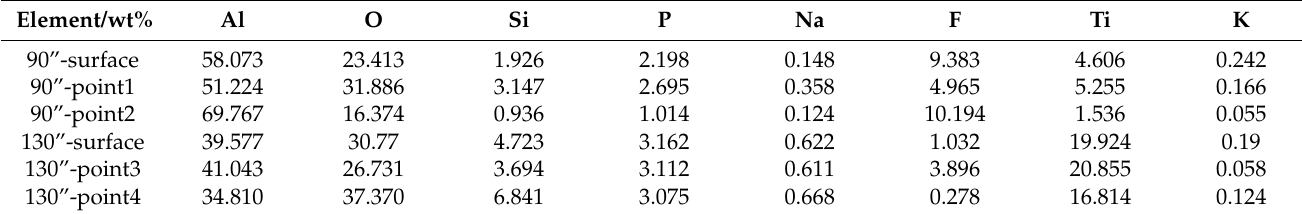
Figure 3. Surface micromorphology of the samples with different treatment times: ( a ) 120 s and ( b ) 180 s. Table 3. EDS results of the coatings for samples with different treatment times.